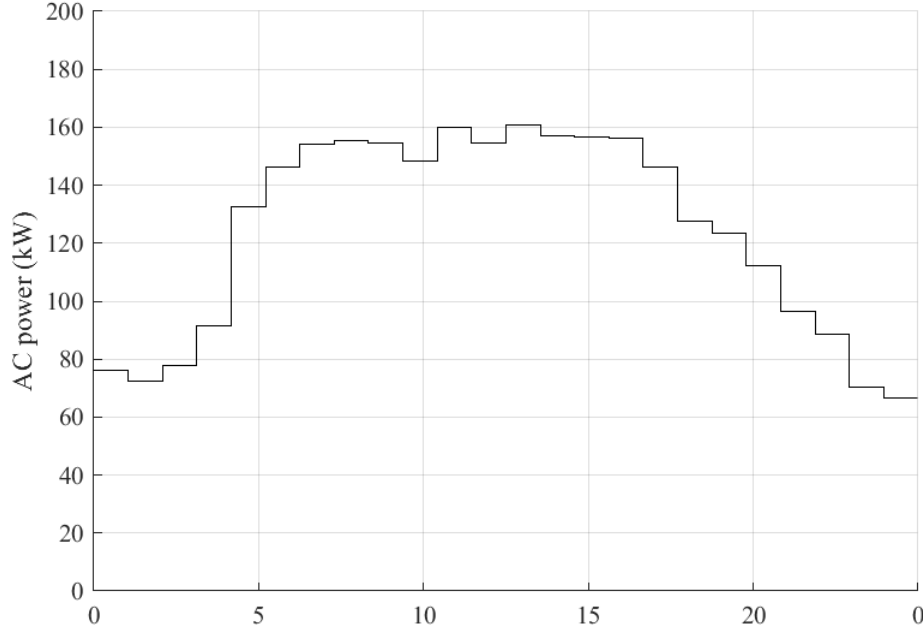
Figure 3. Typical daily case manufacturer electricity demand profile.